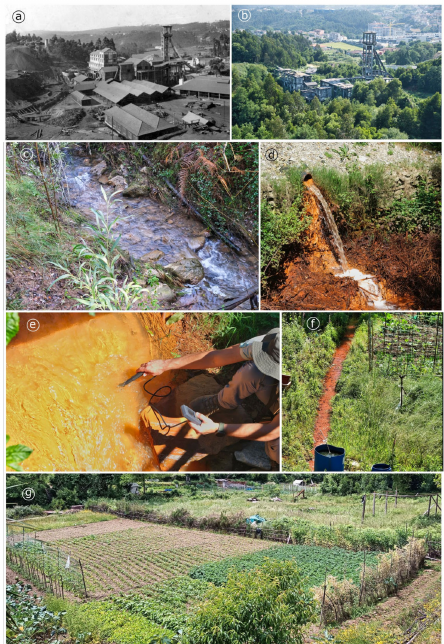
Figure 2. S ã o Pedro da Cova location and geological setting (modified from